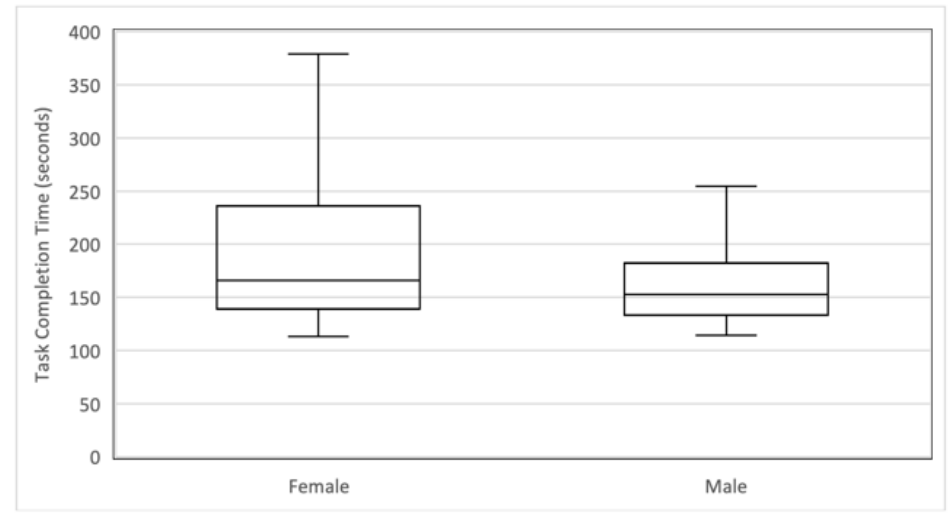
Figure 5. Box plot of task completion time.